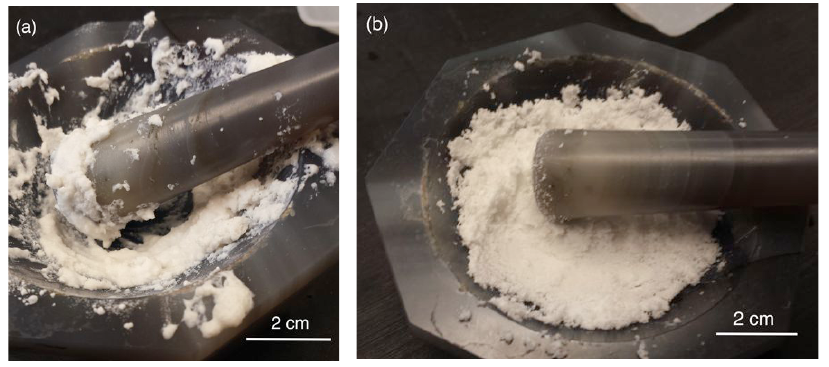
Figure 1. Representative photographs of the paste-like reaction products from · 6H ( a ) Zn(NO ) O and NaHCO precursors, which yields ZnCO 3 2 2 3 Na CO , which yields Zn (CO ) (OH) . 2 3 5 3 2 6